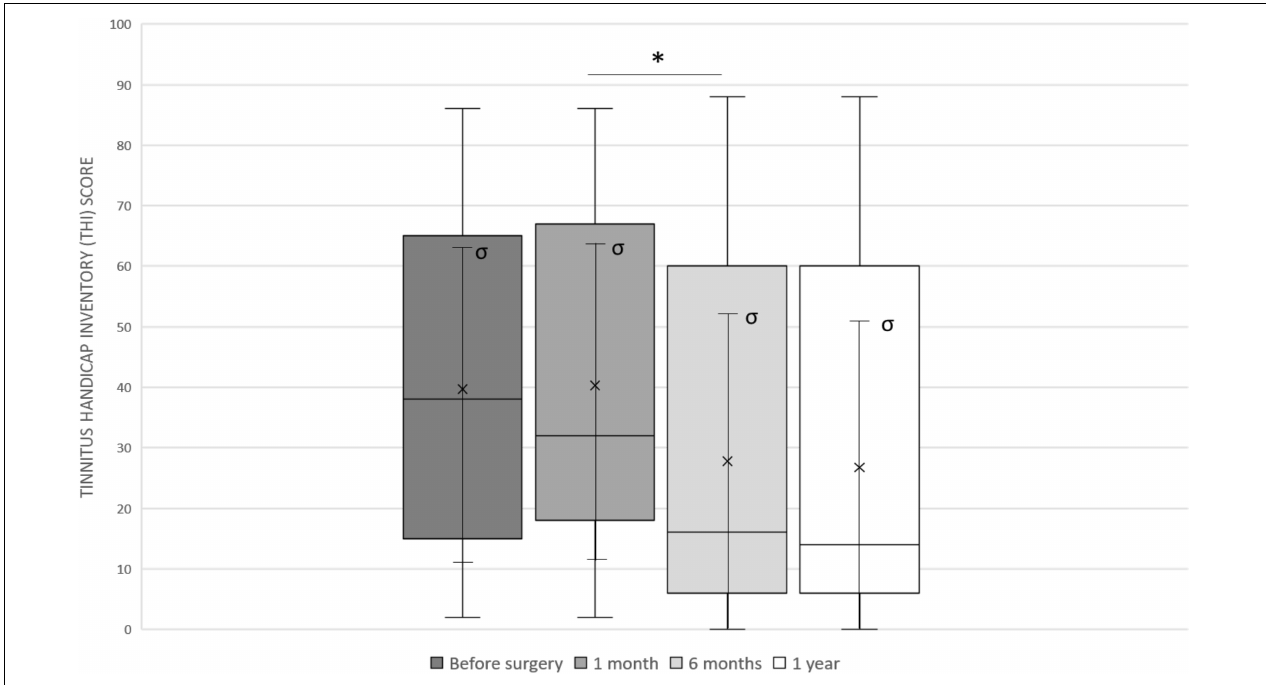
FIGURE 3 | The Tinnitus Handicap Inventory (THI) trend in our sample: before surgery (mean 39.7 ± 27.2), 4 weeks after surgery (mean 40.3 ± 26.7), after 6 months (mean 27.8 ± 29.5) and after 1 year (mean 26.7 ± 28.9). Median values are displayed as a horizontal line, mean values as x, standard deviation as σ . We used t -test for statistical analysis. ∗ p < 0.05.